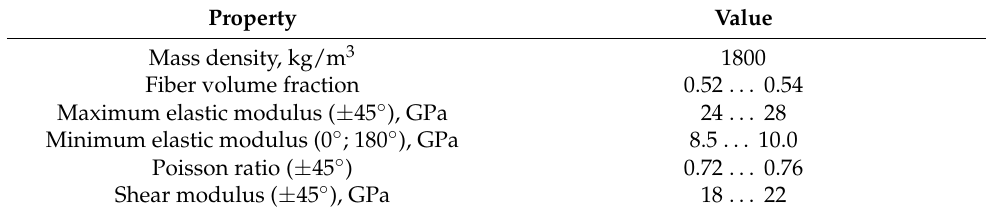
Table 2. Physical and mechanical properties of post-cured epoxy resin. Property